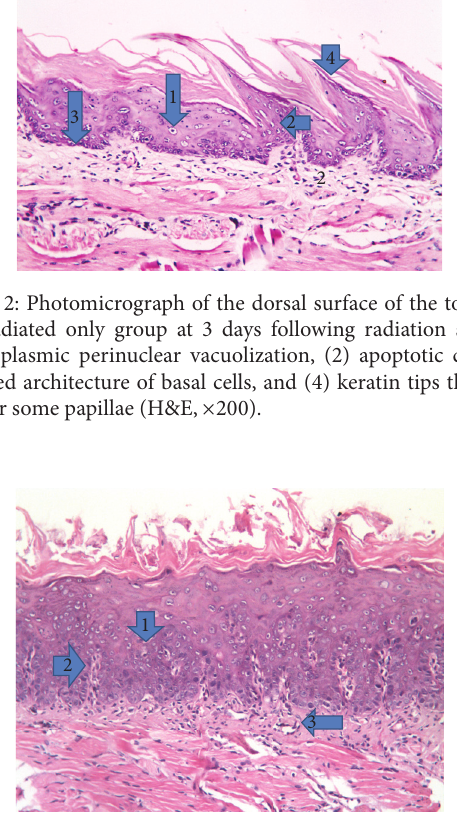
Figure 3: Photomicrograph of the dorsal surface of the tongue of the irradiated only group at 7 days following radiation showing (1) cytoplasmic perinuclear vacuolization, (2) normal architecture of basal cells, and (3) small blood vessels (H&E, ×